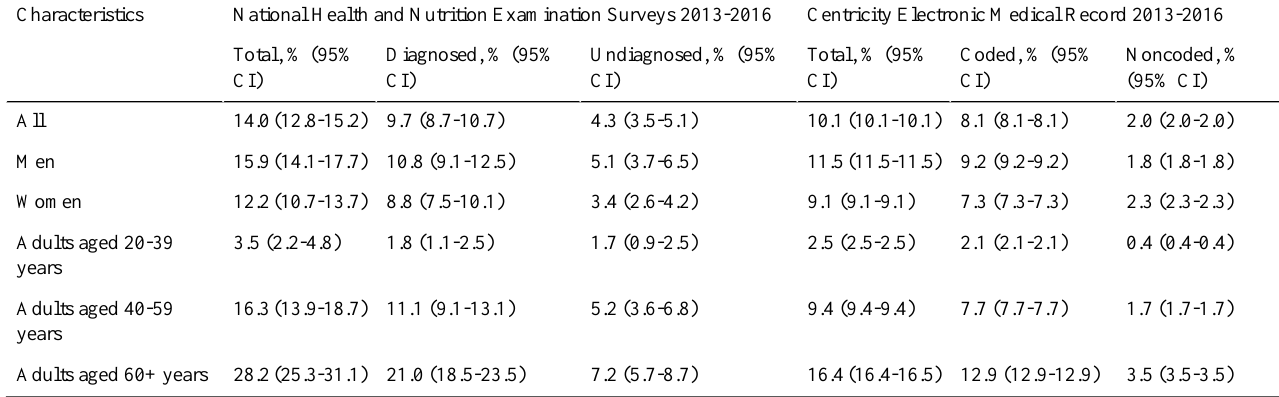
Table 3. The prevalence of diabetes in adult